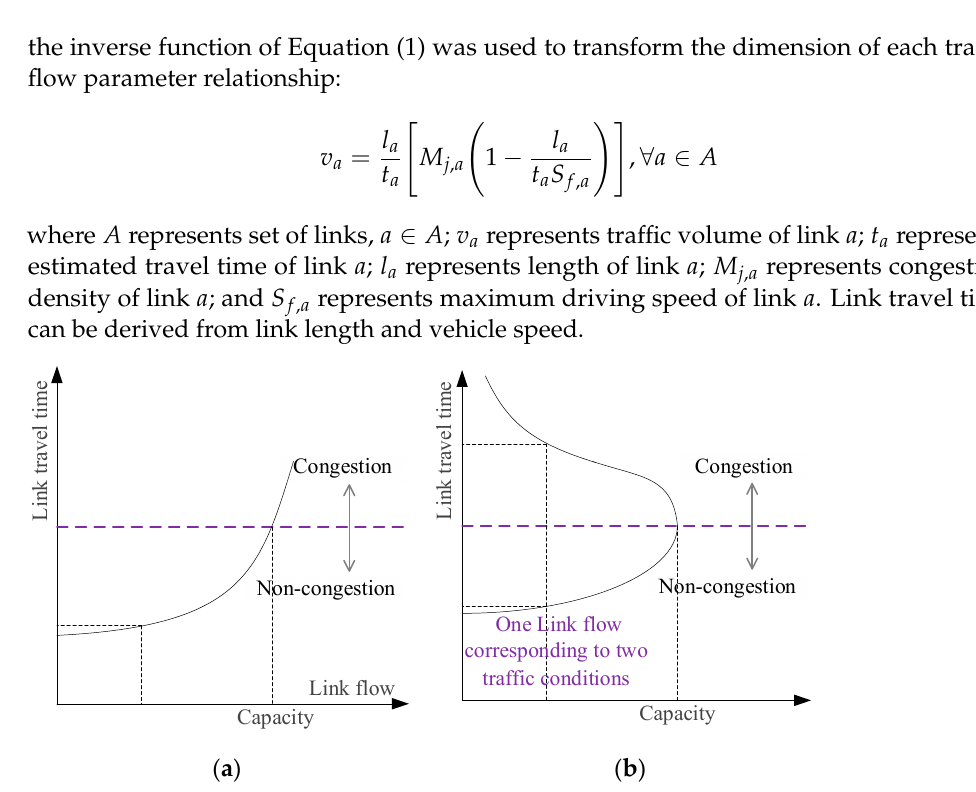
Figure 1. Performance function of link travel time. ( a ) Traditional assumption. ( b ) Actual situation.